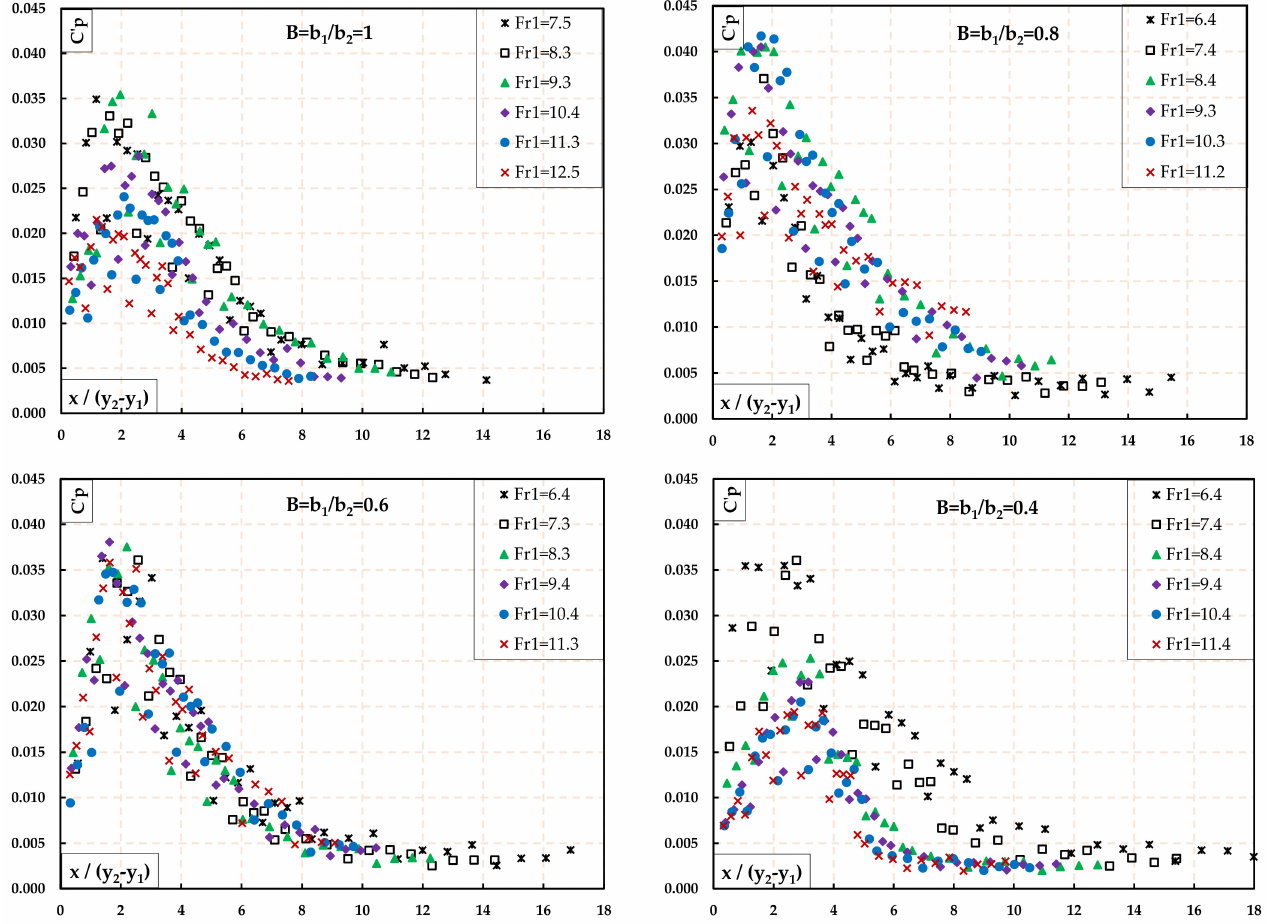
Figure 4. Dimensionless RMS of the pressure fluctuation versus position in the hydraulic jump for different expansion ratios and Froude